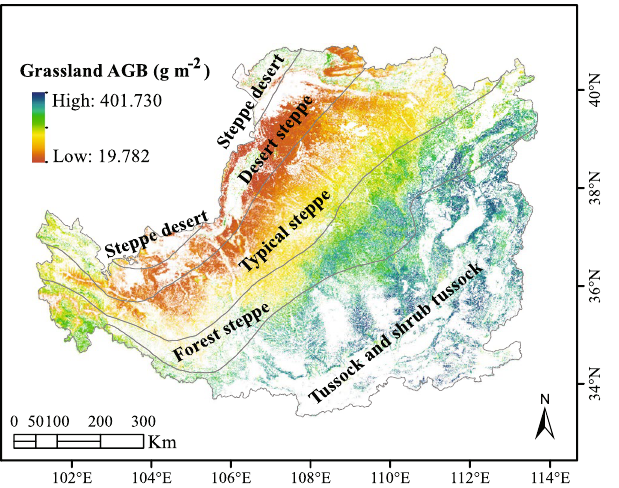
Figure 1. Spatial variation in the grassland AGB on the Loess Plateau. The map was generated using ArcMap Version 10.0 (http://www.esri.com/) and R Version 3.1.3